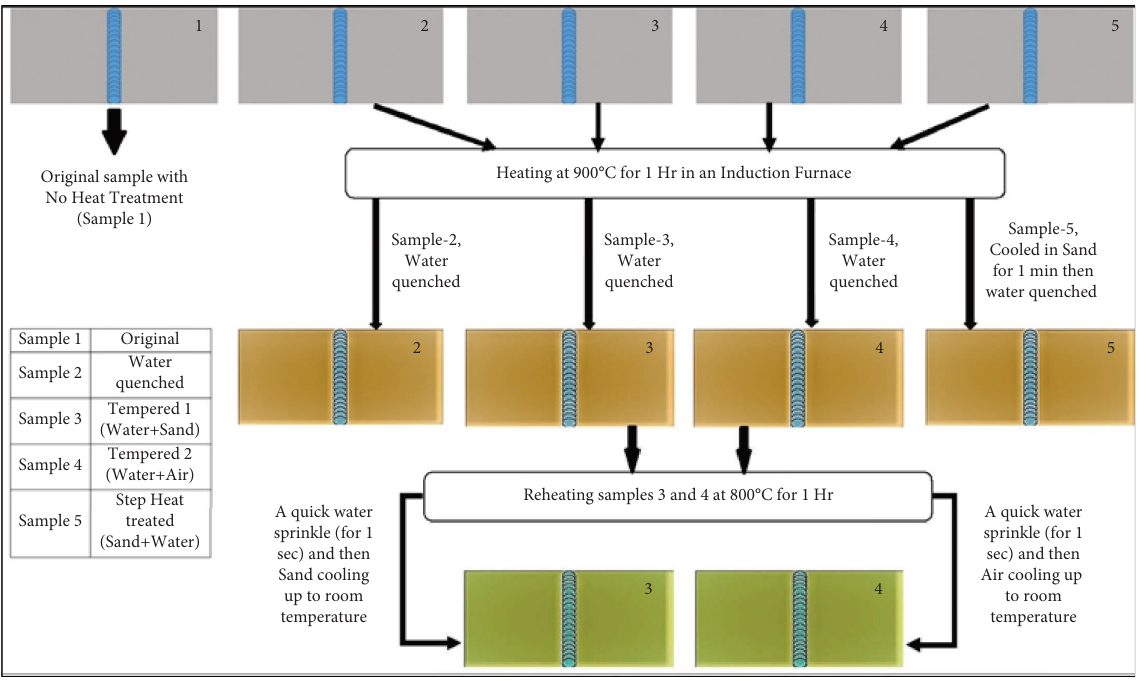
Figure 1: Outline of the experimental work including welding, heat treating, and